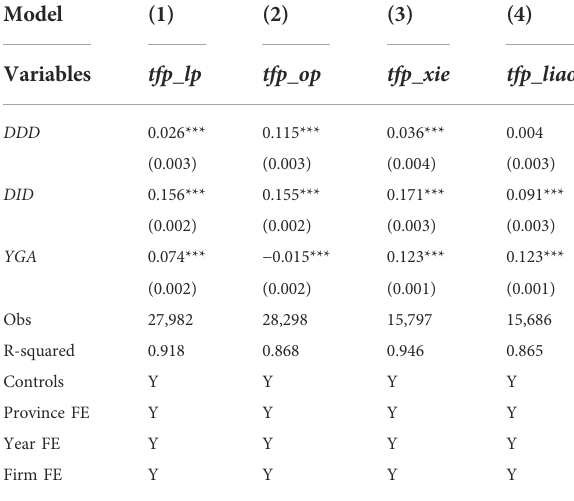
TABLE 7 Baseline regression with different dependent variables. TABLE 8 DDD estimation